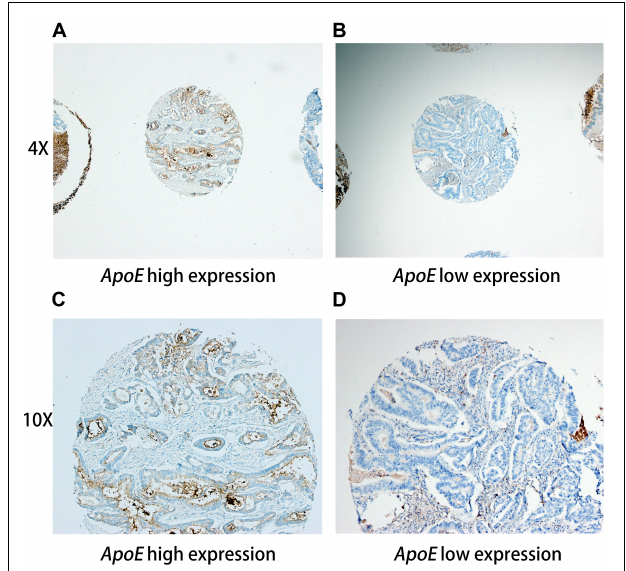
FIGURE 1 | Representative immunohistochemistry staining pictures of ApoE expression in CRC tissues Tissue high expression (4X for A , 10X for C ) and low expression (4X for B , 10X for D ) for the ApoE protein are shown. Each of punched samples is 1.0 mm in the tissue